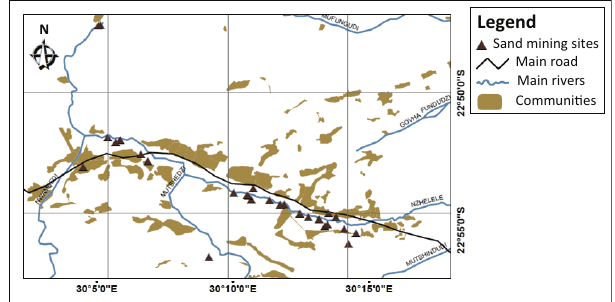
FIGURE 1: Spatial distributions of sampled sand mining